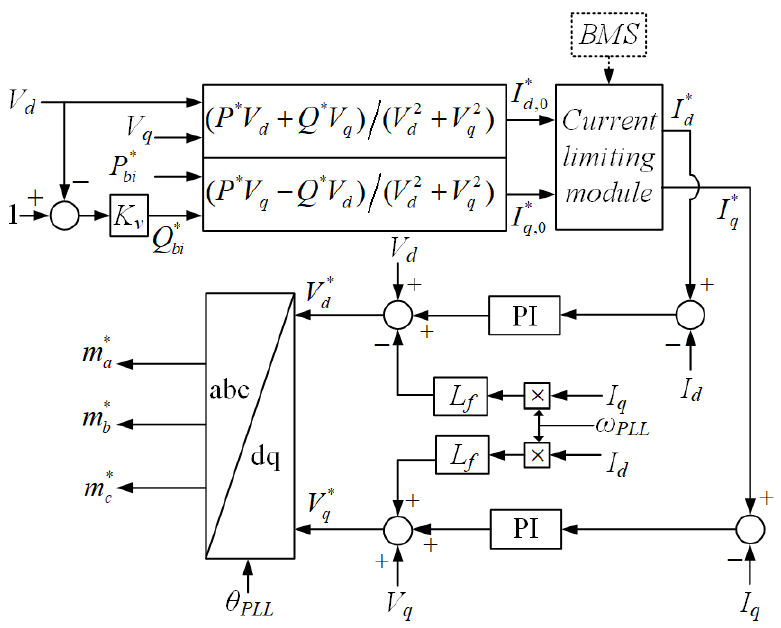
Figure 3. BESS converter controller.